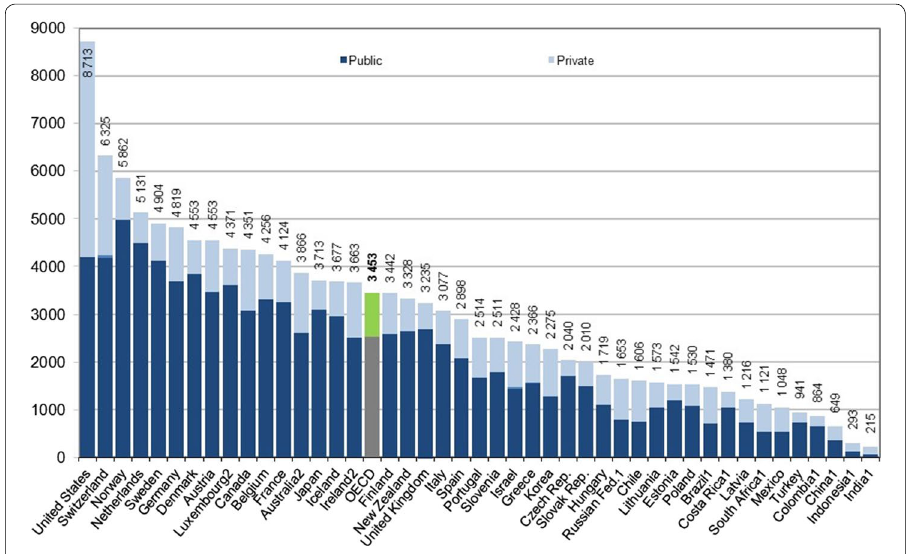
Fig. 1 US healthcare expenditures vs. other OECD countries